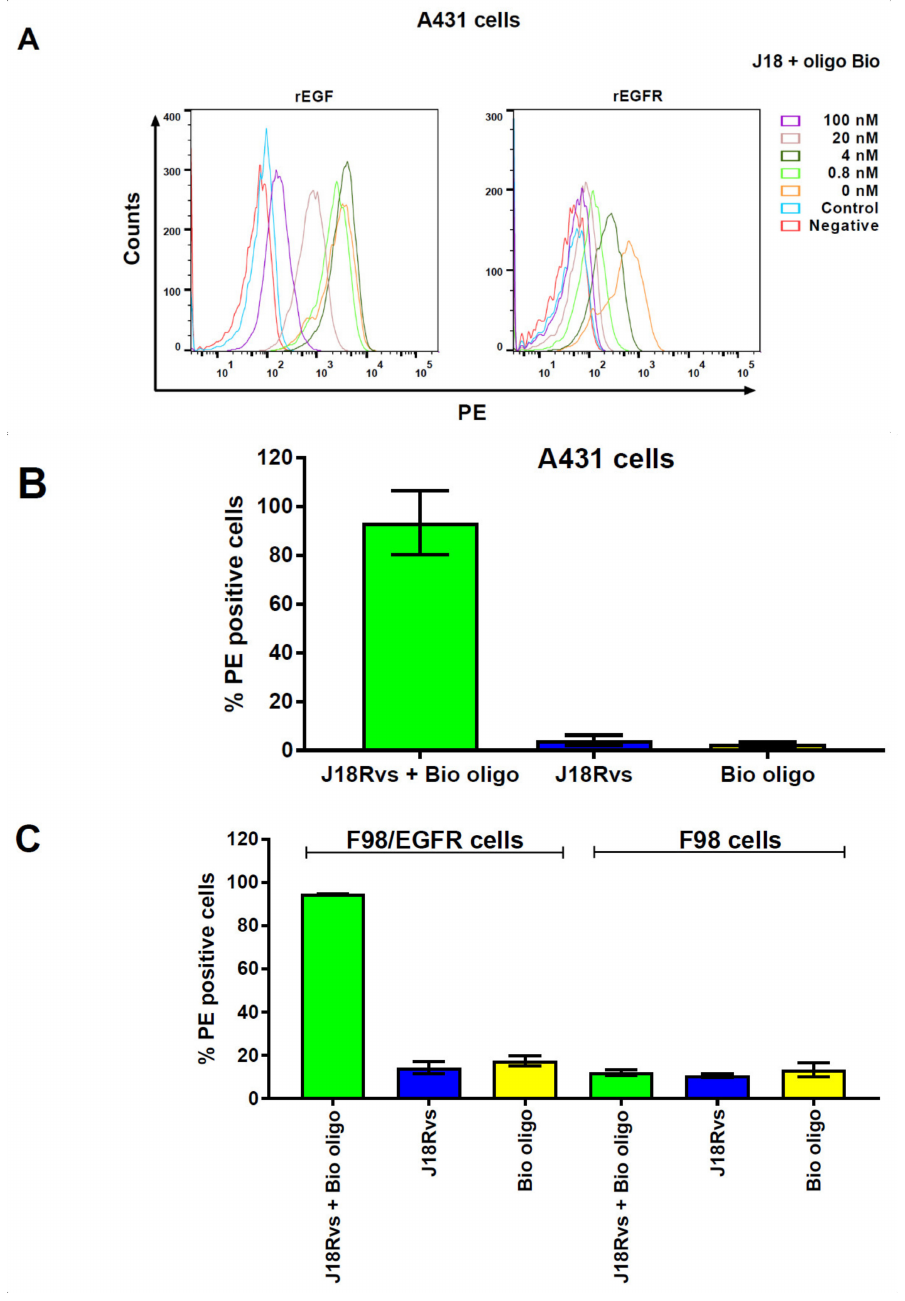
Figure 3. RNA aptamer binding to A431 cells and F98/EGFR cells. ( A ) J18 aptamer binding to A431 cells in the presence of rEGF ranging from 0 nM to 100 nM (left panel) or rEGFR ranging from 0 nM to 100 nM (right panel). Control: SA19 aptamer directed against streptavidin. The aptamer binding was assessed using the oligo Bio bound to the PE streptavidin. Negative: cells not exposed to the J18 aptamer. ( B ) J18 Rvs aptamer binding to A431 cells. The aptamer binding was determined using the Bio oligo bound to the PE streptavidin. ( C ) J18 Rvs aptamer binding to F98/EGFR and F98 cells. Green panels: cells plus J18 Rvs aptamer plus Bio oligo; blue panels: cells plus J18 Rvs aptamer; yellow panels: cells plus Bio oligo. The error bars represent the means ± SD of three independent